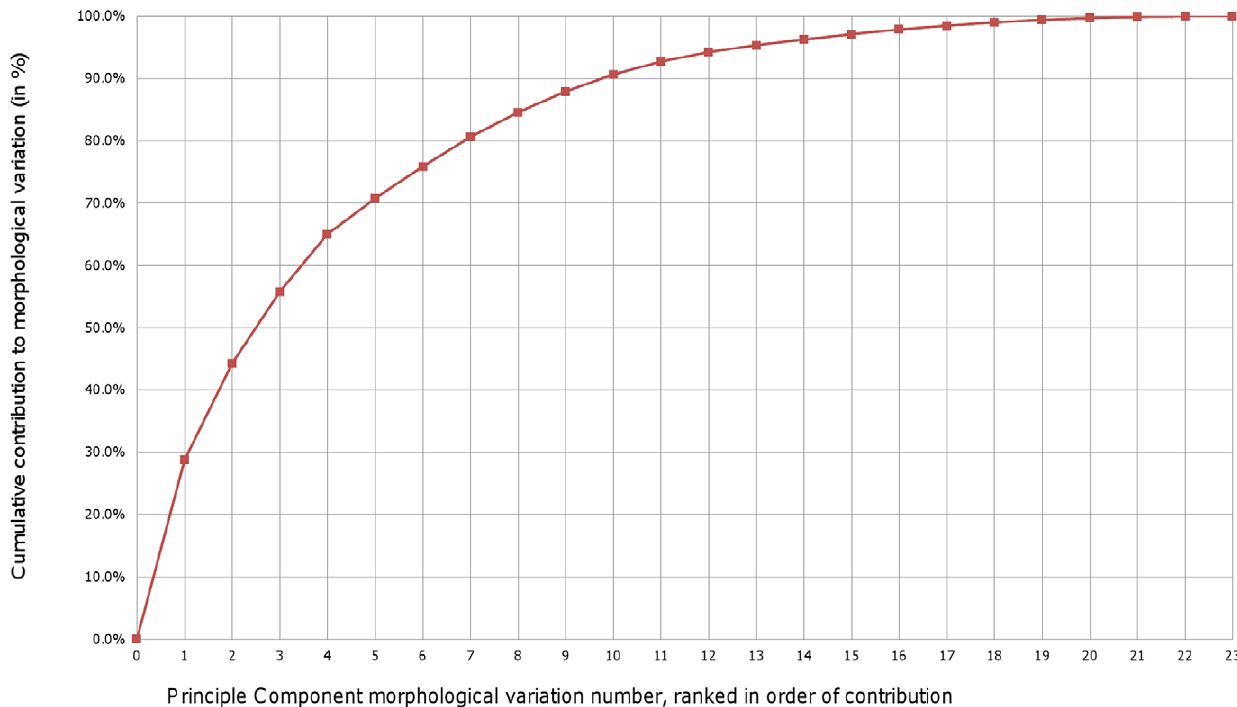
Figure 2. The cumulative percentage of contributions by each MV in the ‘without size’ SSM. doi:10.1371/journal.pone.0034619.g002 PLoS ONE |